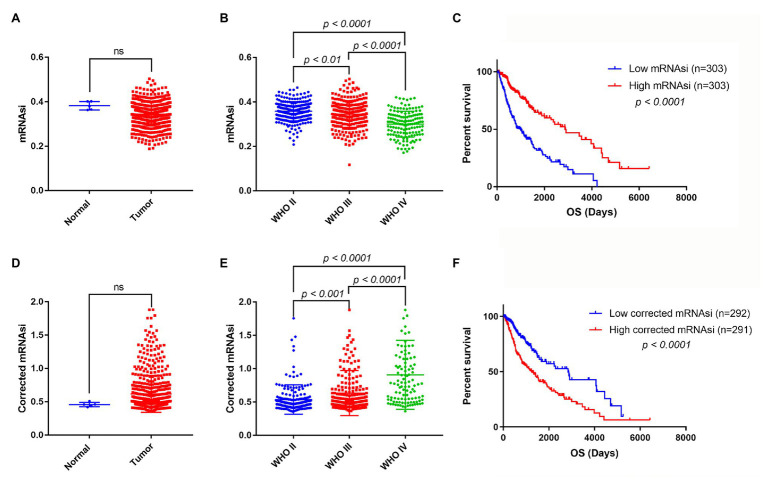
The mRNA expression-based stemness index (mRNAsi), corrected mRNAsi and clinical characteristics in glioma. (A) The expression level of mRNAsi in normal (five samples) and tumor (606 samples) tissues. (B) Expression level of mRNAsi in gliomas of different WHO grades. (C) Kaplan-Meier survival analysis of the relationship between mRNAsi and overall survival (OS). (D) The expression level of corrected mRNAsi (mRNAsi/tumor purity) in normal (five samples) and tumor (583 samples) tissues (23 samples cannot calculate the tumor purity). (E) The expression level of corrected mRNAsi in glioma of different WHO grades. (F) Kaplan-Meier survival analysis of the relationship between corrected mRNAsi and OS.